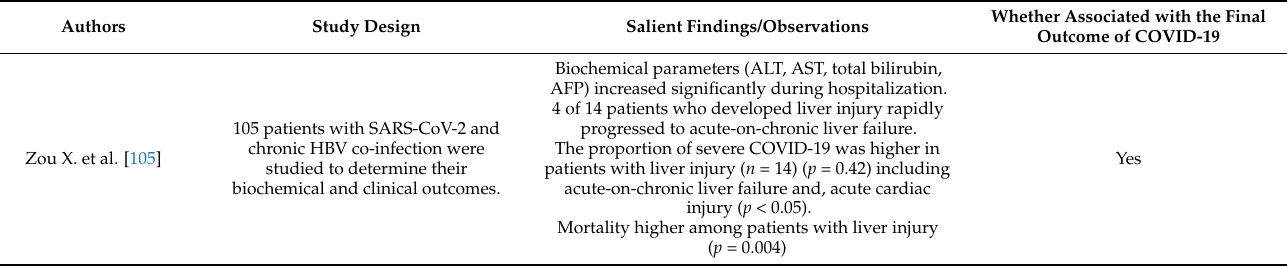
Table 2. Summary of studies on COVID-19 patients with pre-existing hepatitis B virus (HBV) infection.